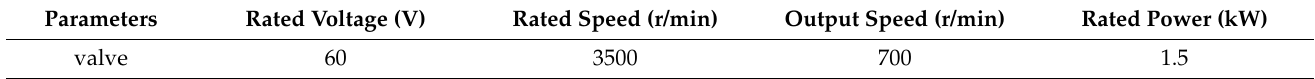
Table 2. Drive motor